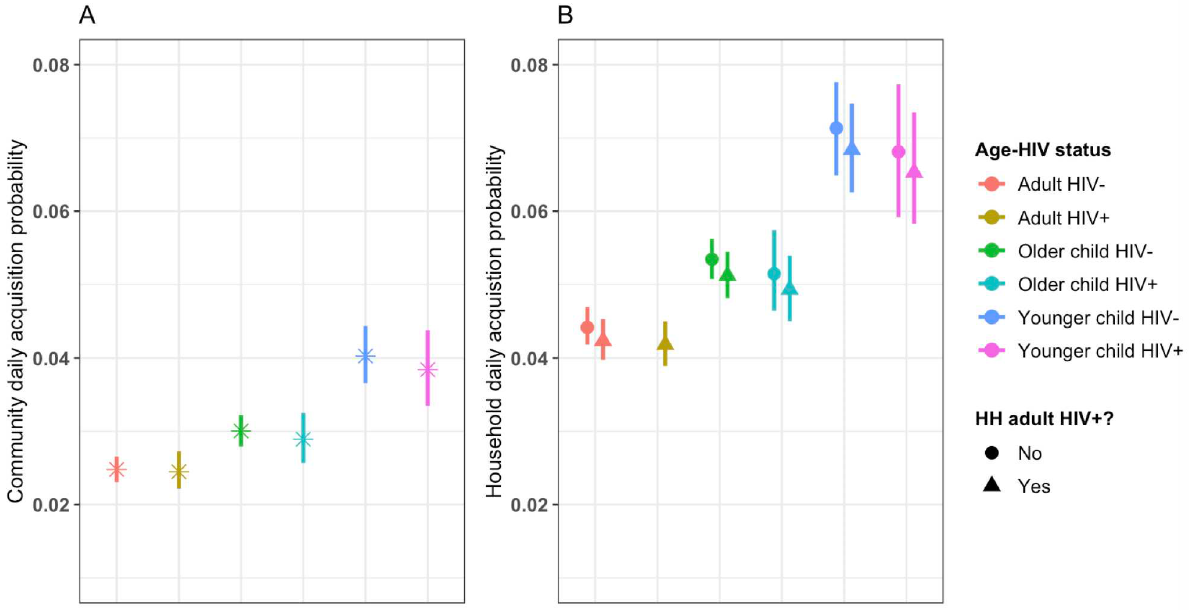
Fig 3. Community and within household (HH) acquisitions of pneumococcal carriage in younger children ( < 5 years-old), older children (5–17 years-old) and adults ( � 18 years-old) in South African households between 2016–2018. Age and human immunodeficiency virus (HIV) stratified estimates of community carriage acquisition probability per day (A) and within household carriage acquisition probability per day over the total follow-up period (B), comparing household without HIV-infected adult(s) (HIV-) to households with HIV-infected adult(s)